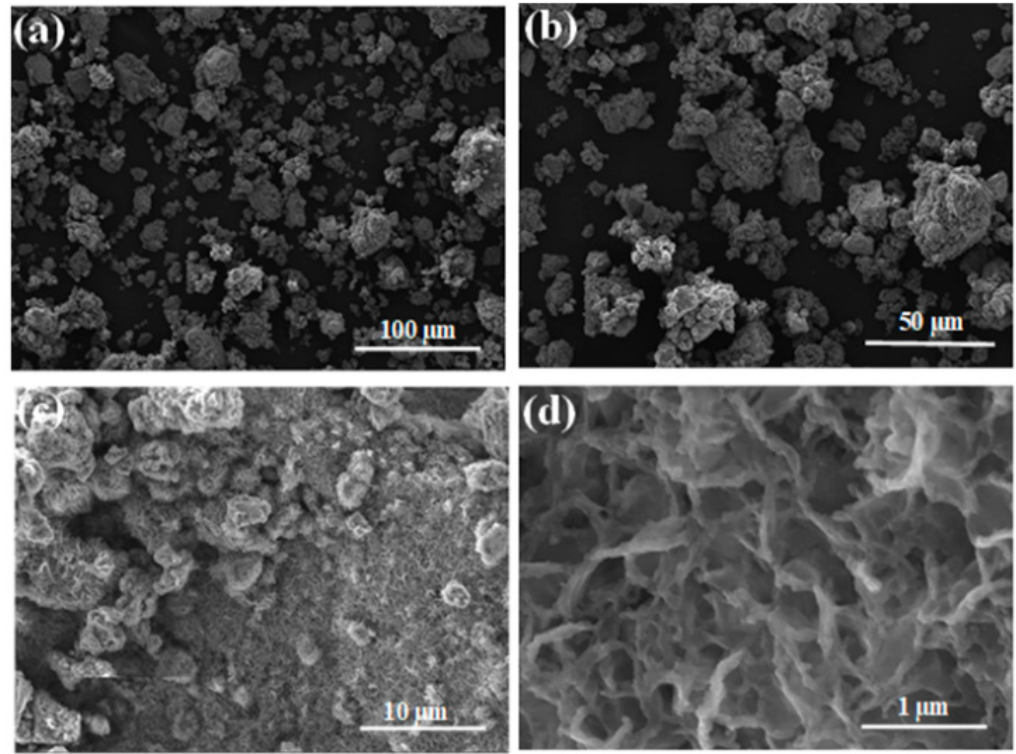
Figure 5. SEM micrographs of MA Mn-Al-Fe after RB5 degradation at different magnifications. Scale bars: ( a ) 100 µm, ( b ) 500 µm, ( c ) 10 µm and ( d ) 1 µm.